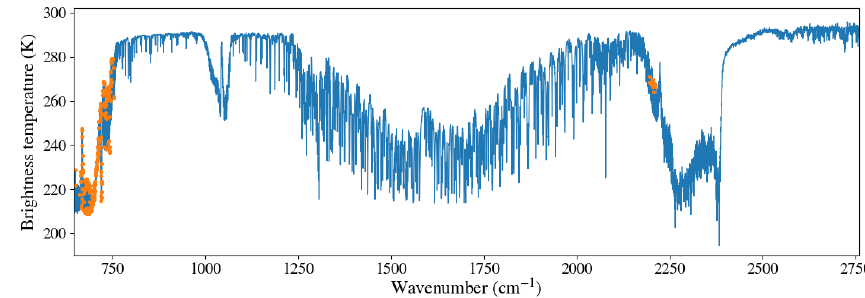
Figure 1. IASI clear-sky spectrum in brightness temperature in kelvin (blue), with the selected channels in orange.